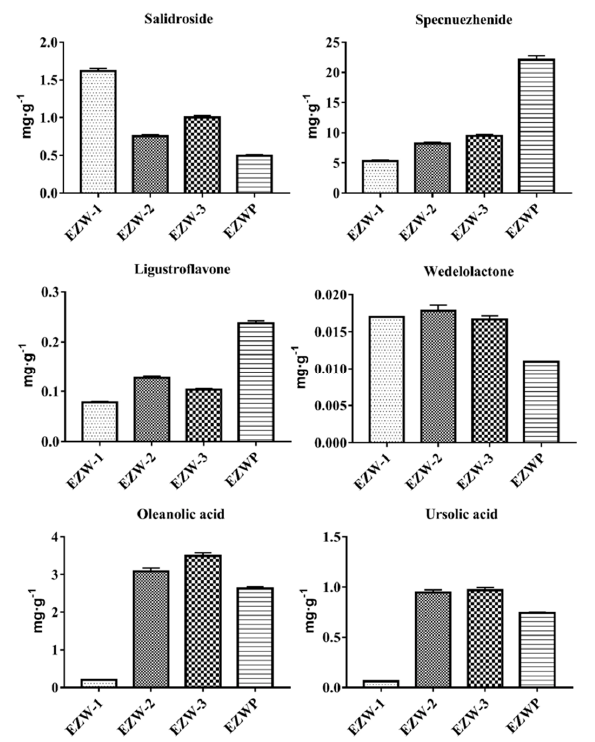
Figure 2. The contents of the six components from different EZW samples. Table 2. Decision matrix of the pairwise comparison of indexes and results of the multi-index weight. Salidroside Specnuezhenide Ligustroflavone Wedelolactone Oleanolic Acid